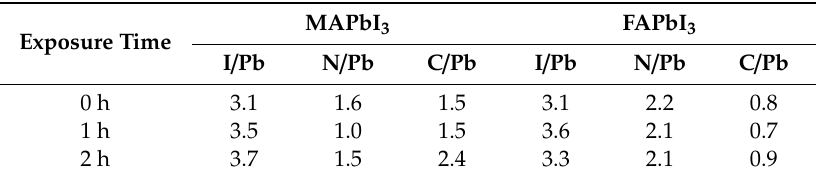
Figure 2. The relative intensities change after di ff erent water vapor exposure period. ( a ) Elemental intensity changes of MAPbI 3 sample. ( b ) Elemental intensity changes of FAPbI 3 sample. Table 1. Atomic ratio of di ff erent elements obtained by XPS from MAPbI 3 and FAPbI 3 before and after water vapor